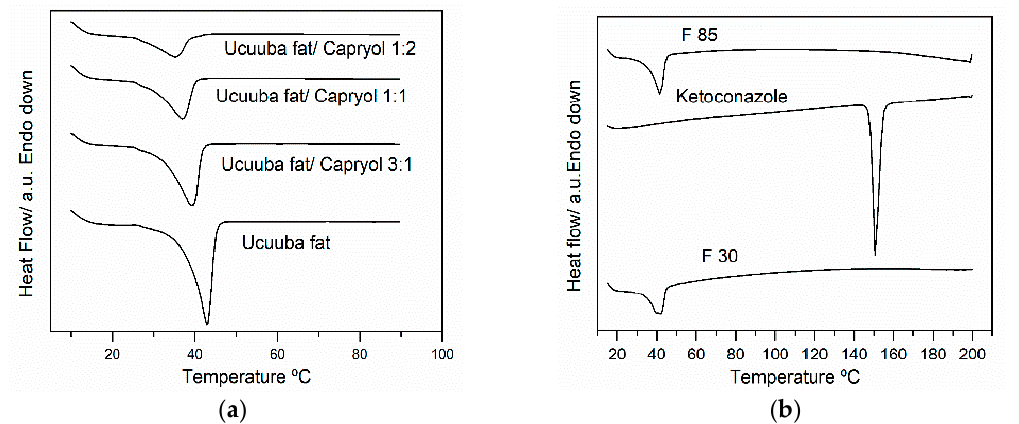
Figure 7. DSC traces of Ucuùba fat/Capryol™ 90 mixtures ( a ) and of the optimized Ucuùba fat NLC formulations F 30 and F 85 along with ketoconazole raw material ( b ).